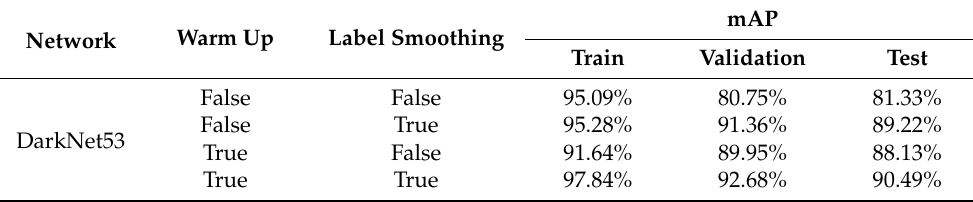
Table 6. YOLOv3 model performance results for culm area detection of